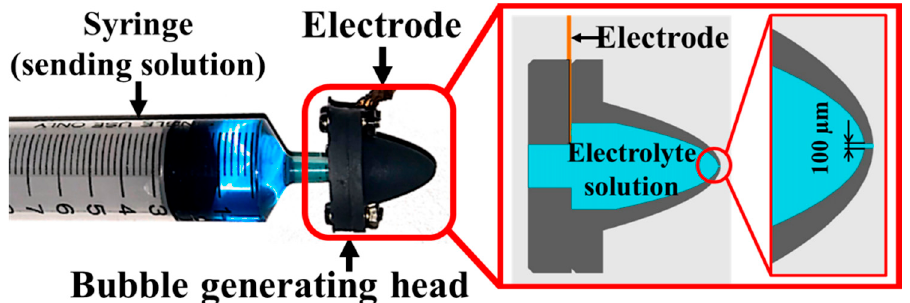
Figure 1. Overall view and structure of the device, which is composed of a syringe and a bubble generating head. The head was made with a 3D printer. It has a small hole at the tip and a hollow space inside. The space is filled with an electrolyte solution and the electrode is in contact with the solution.